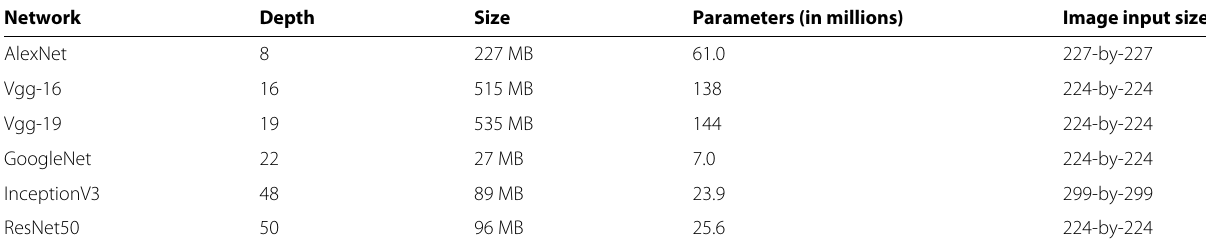
Table 2 Details of fine-tuned CNNs Network Depth